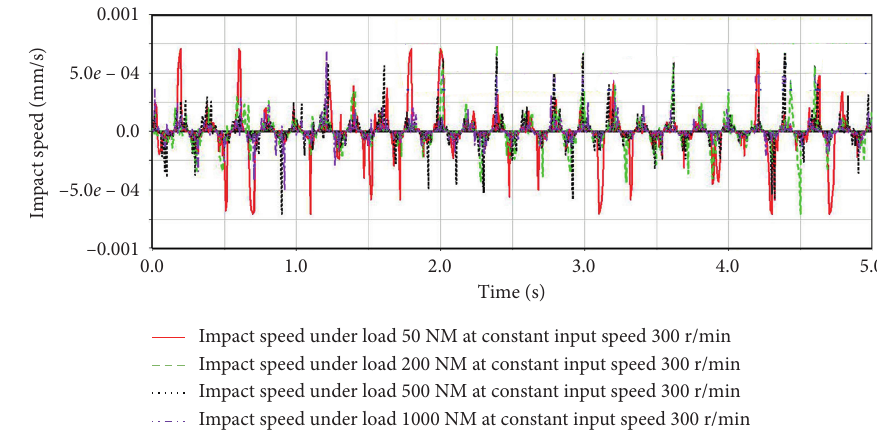
Figure 13: Impact speed of second-stage face gear pair under variable load.